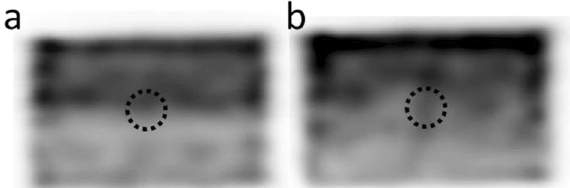
Fig. 6 Reconstructed non‑uniform background images generated using non‑uniform Poisson resampling. Dashed circles indicate the approximate location of source of interest. a Down sampling in half of the phantom only, with smooth transition to no down sampling in second half of phantom (profile indicated by dashed line in Fig. 7). b Linear down sampling performed across the entire phantom length (phantom profile indicated by solid line in Fig. 7)